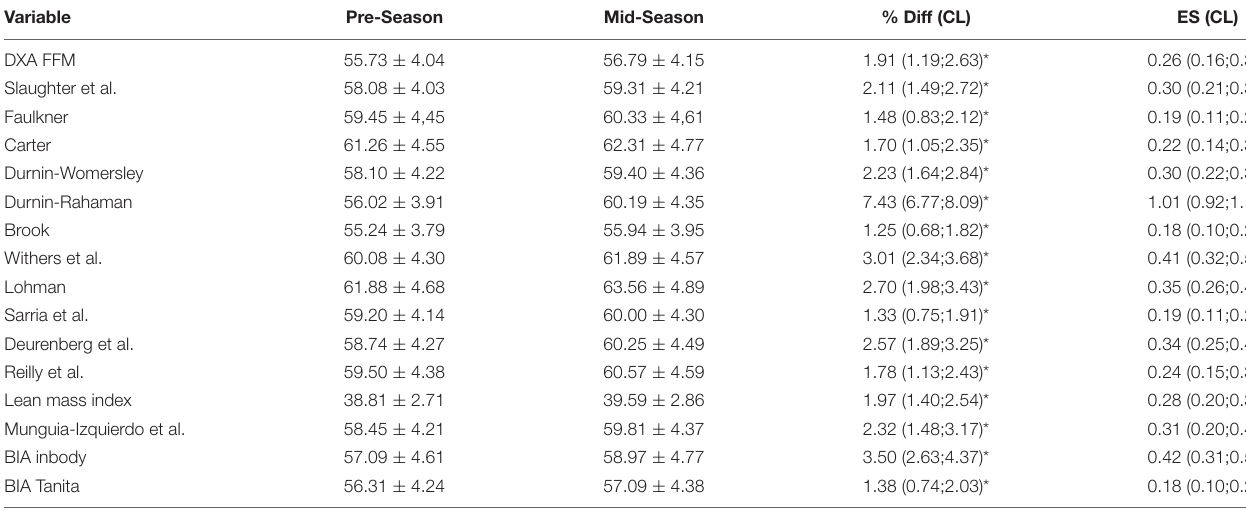
TABLE 2 | Change in estimation of FFM with DXA and other practical estimates of FFM between the pre- and mid-season. Variable